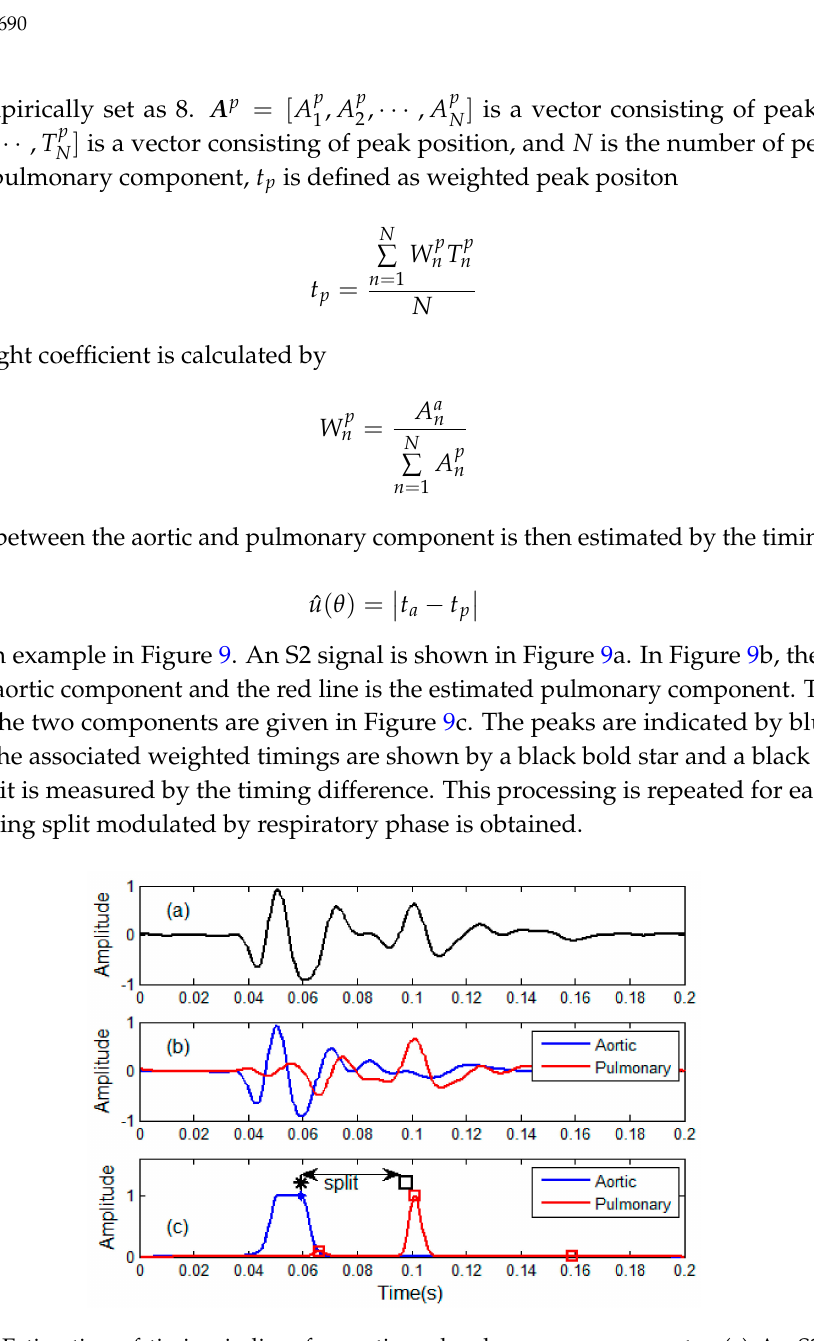
Figure 9. Estimation of timing indices for aortic and pulmonary components. ( a ) An S2 signal, ( b ) Estimated aortic and pulmonary components, ( c ) Timing indices estimated from weighted peak positions. The split is estimated by the timing difference between the black star and the black